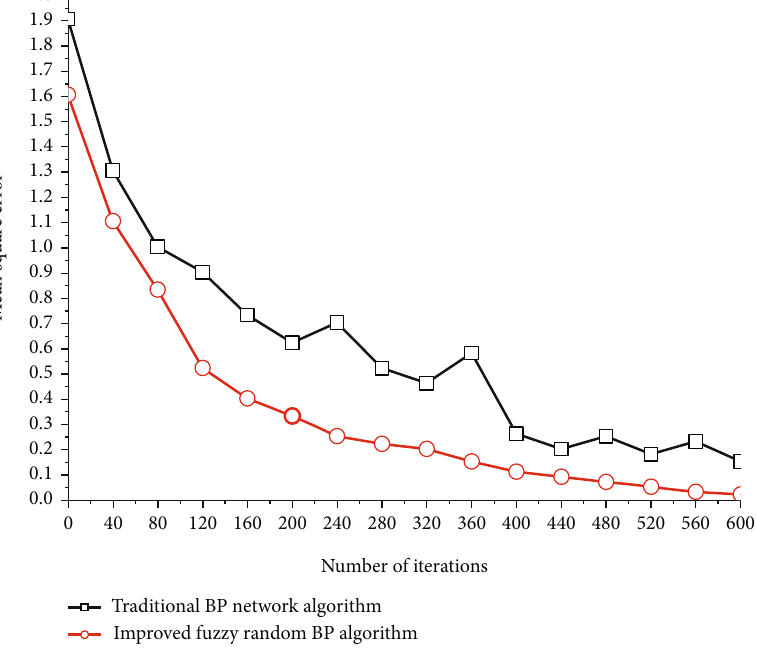
Figure 7: E ffi ciency comparison between the traditional and improved